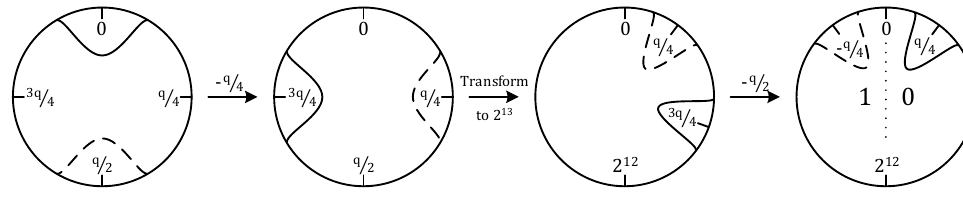
Figure 7: Visualization of the masked decoder of Oder et al.